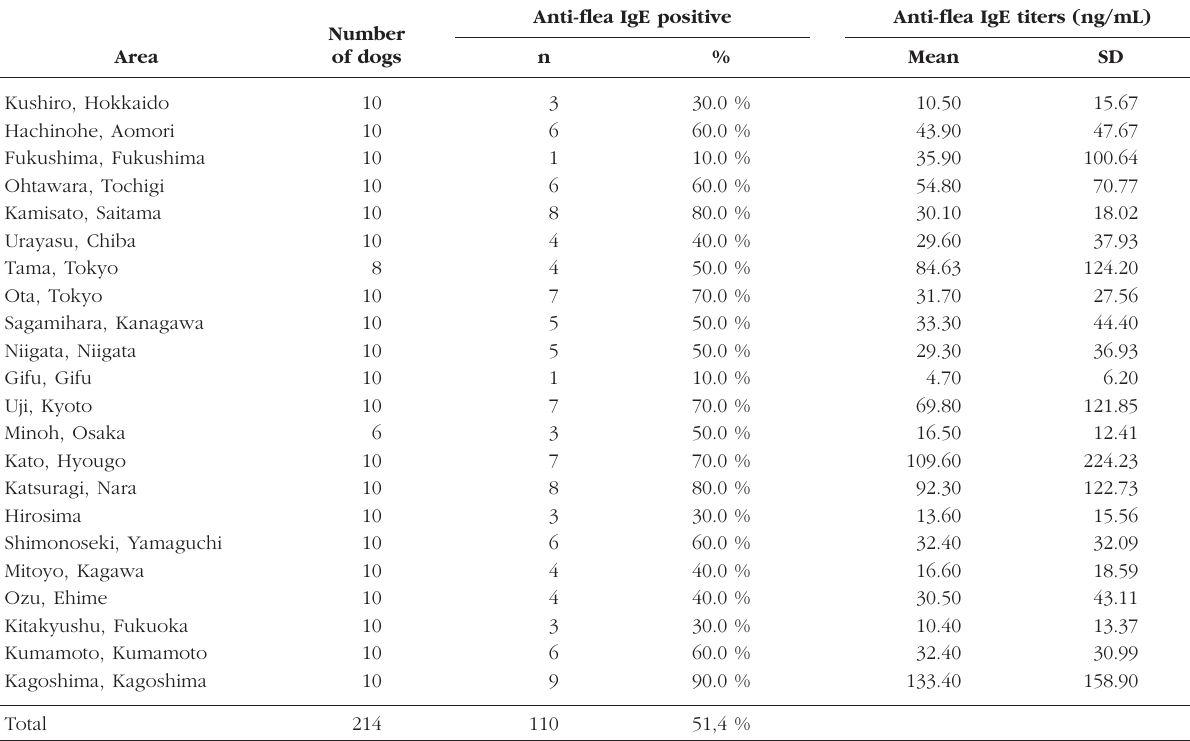
Table II. – Results of anti flea-IgE by